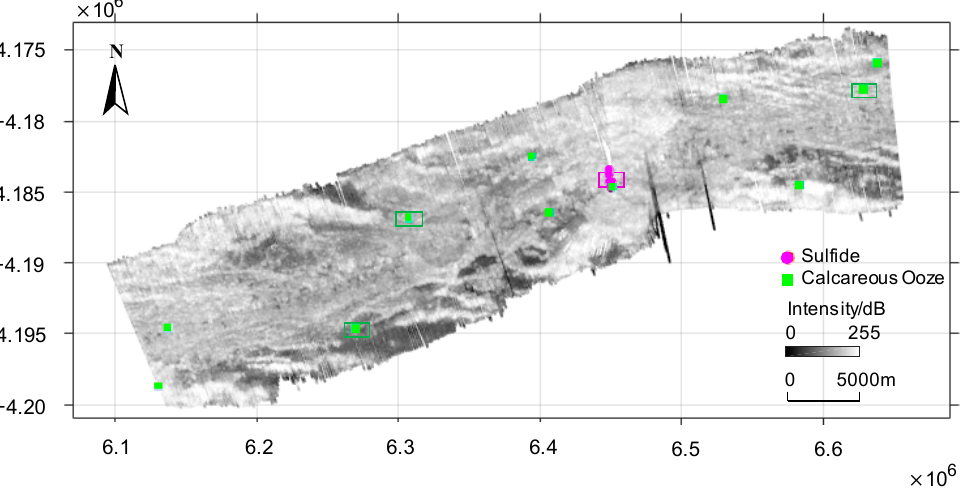
Figure 7. Location and type distribution of seabed geological sampling points in Longqi hydrothermal area.